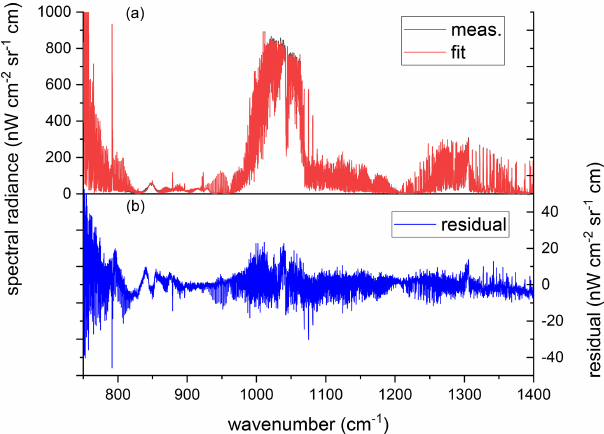
Figure A2. (a) Measurement after subtraction of the Planck func- tion and the result of the broadband fit. (b) The residual (measure- ment minus fit; the right ordinate) enlarged by a factor of